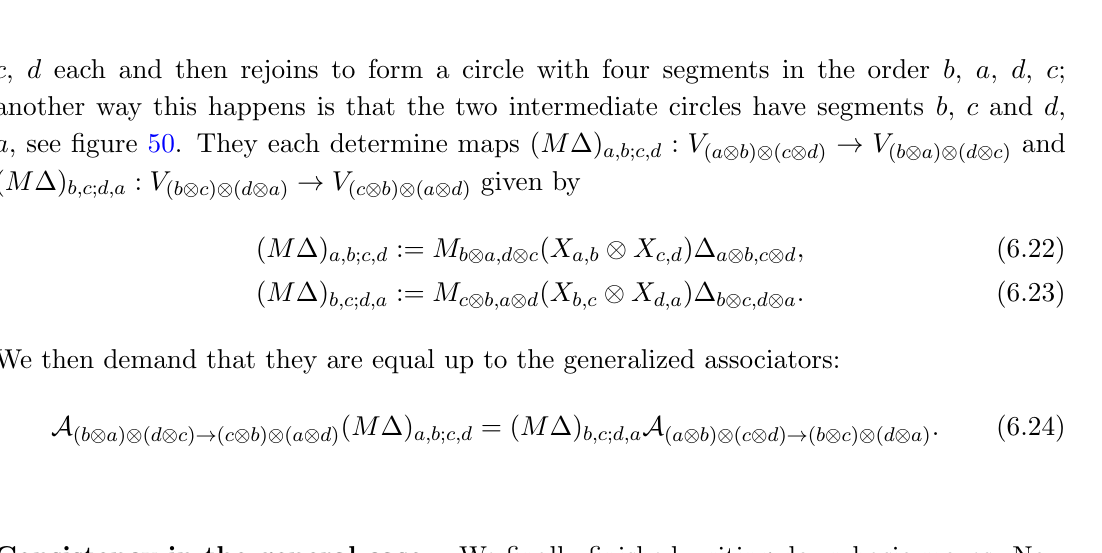
Figure 50 . Two ways a circle splits into two and then rejoins. They should be equal up to the action of X and the